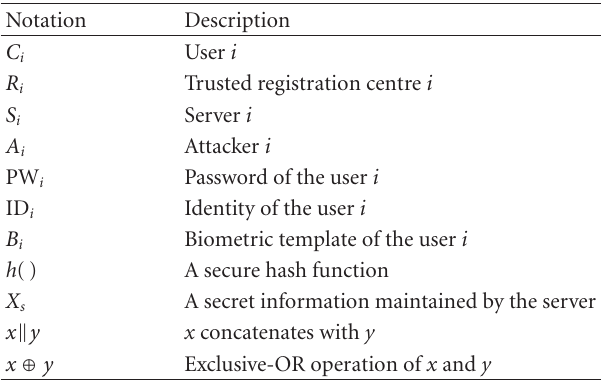
Table 1: Notations used in this